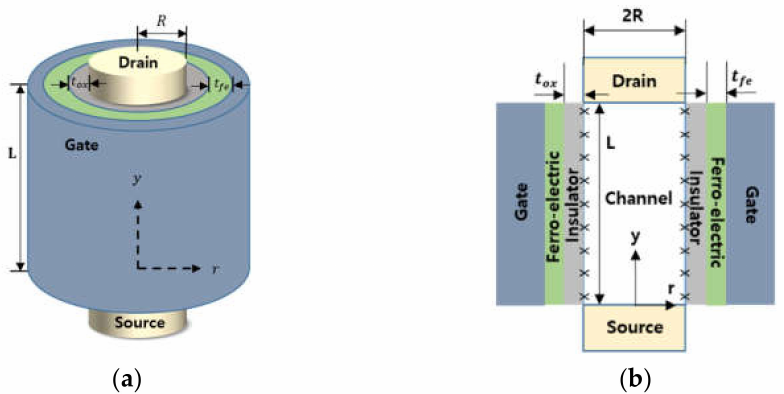
Figure 1. ( a ) Three-dimensional scheme of the NC-GAA FET; ( b ) cross-section of the NC-GAA